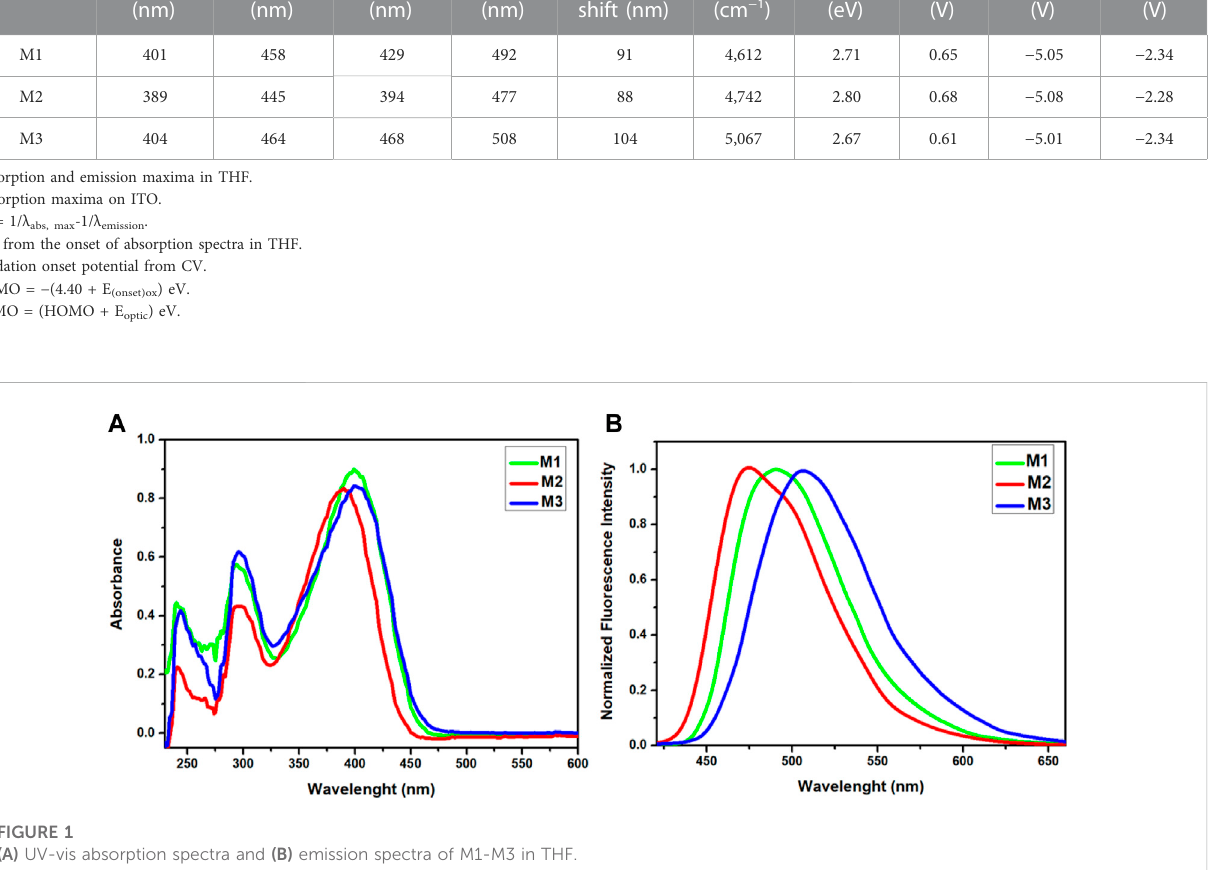
TABLE 1 Optical and electronic data of M1-M3. Molecules